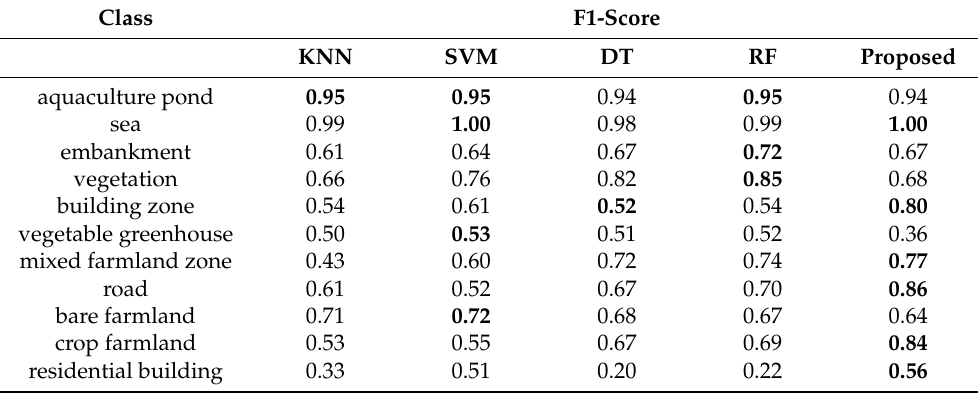
Table 4. Comparison of F1 scores using the KNN, SVM, DT, RF, and proposed methods for experi- mental scene A. Bold represents the highest precision of a same class among these methods.